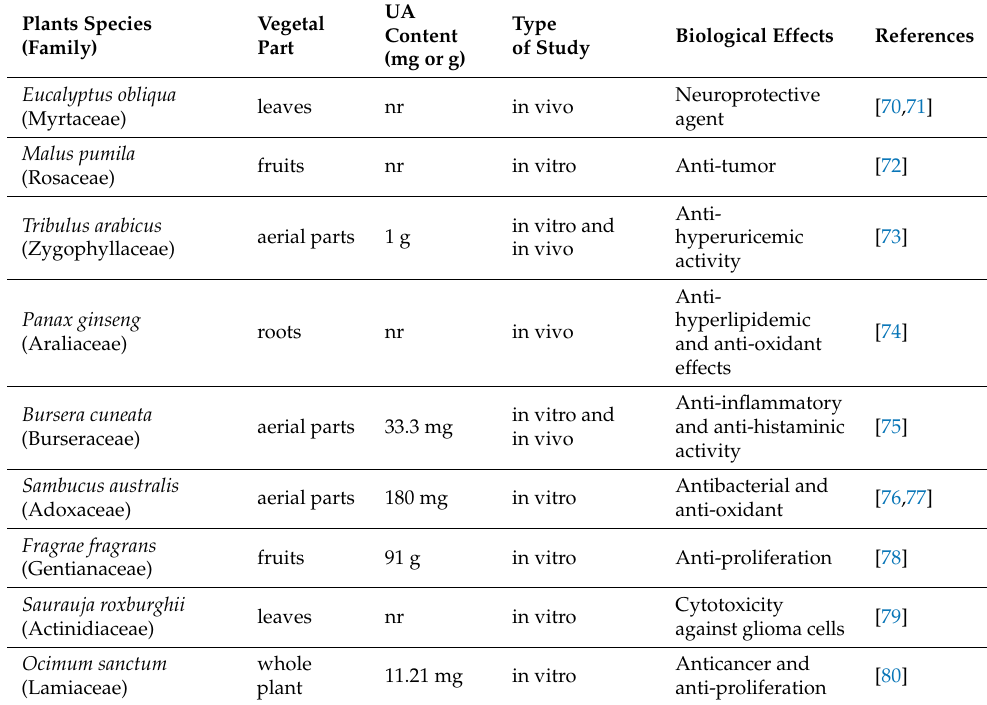
Table 1. Sources of UA with their biological